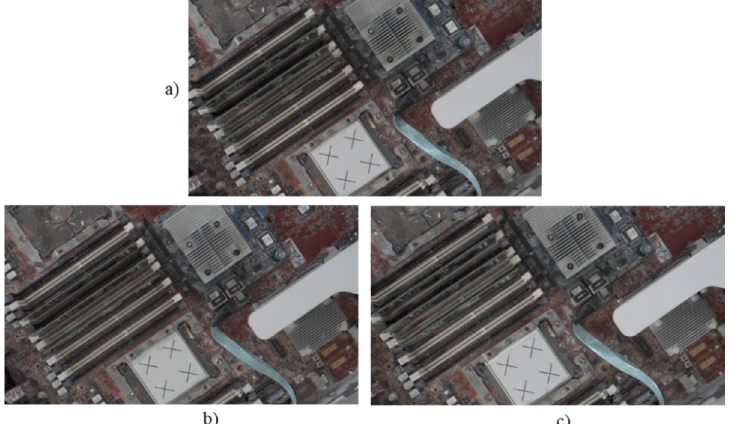
Figure 19. Position correction system test results for two random positions. Standard image without displacement or rotation shown in ( a ) Figure 14d, and new images after ( b ) the first random position shown in Figure 15a and ( c ) the second random position shown in Figure 15b.